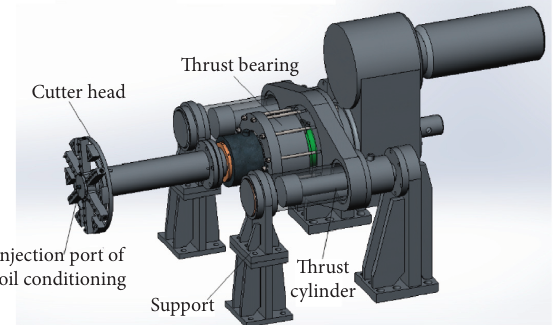
Figure 5: Propulsion and cutting system.